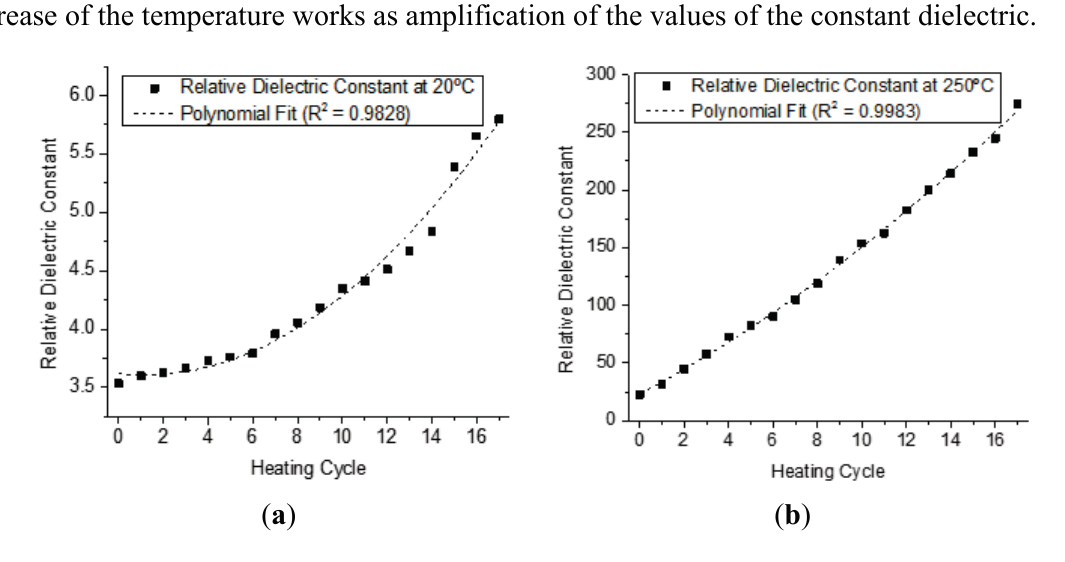
Figure 9. Value of the Dielectric Constant at 20 °C in ( a ) and at 250 °C in ( b ), obtained after each one of the seventeen consecutive heating cycles of the soybean oil samples.